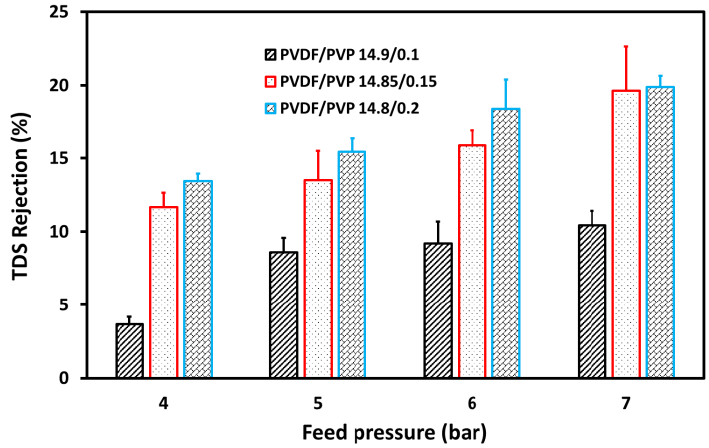
Figure 9. TDS rejection at various feed pressures in the UF process for tofu wastewater.